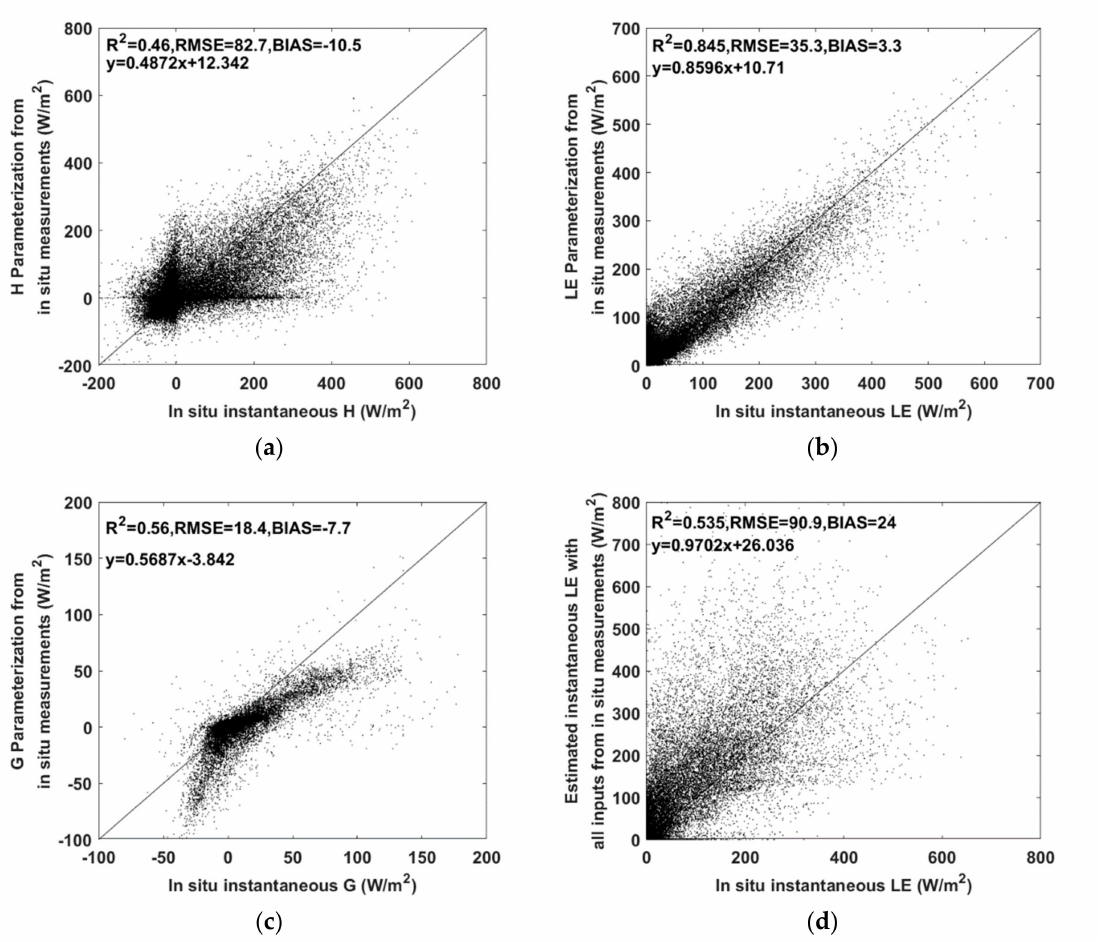
Figure 9. Evaluation of: ( a ) sensible heat flux ( H ); ( b ) latent heat flux ( LE ); ( c ) soil heat flux ( G ) parameterization by in situ measurements; and ( d ) estimated instantaneous LE with all inputs from in situ